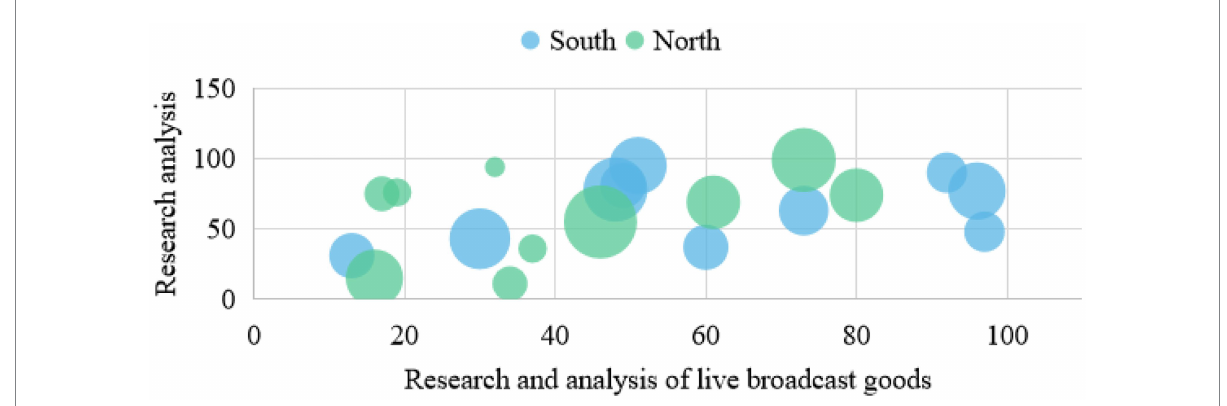
FIGURE 4 Research and analysis diagram of heat of live broadcast goods.